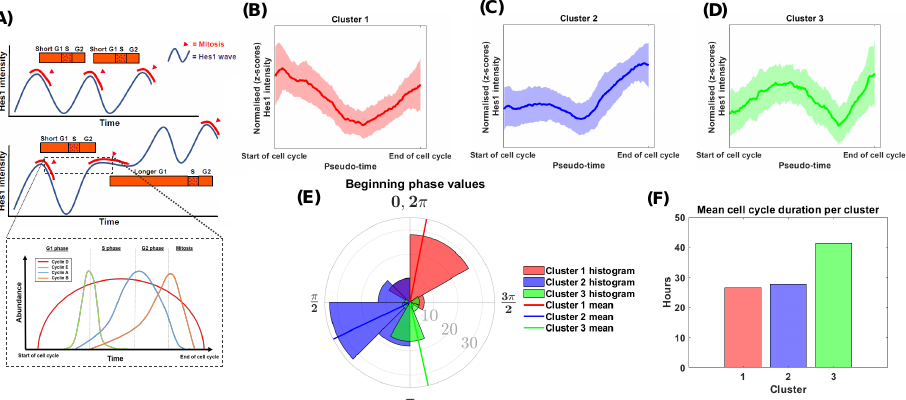
Figure 1. Graphs and schematics representing the results in [26]. ( A ) Schematic illustrating that cell division at a peak in Hes1 yields regular and consistent cell cycle durations ( top panel ) whereas division at a trough gives rise to longer cell cycles (middle panel). Schematic of cyclins (cell cycle proteins) that rise and fall in abundance once every cell cycle ( bottom panel ). ( B – D ): There exist three distinct mitosis to mitosis dynamic behaviours of normalized (z-scored) Hes1 expression: Cluster 1 with high-low-high, Cluster 2 with medium-low-high and Cluster 3 with low-high-low- high dynamics (red, blue, green lines, respectively, shading is ± one standard deviation). ( E ) The momentary position within the oscillation (i.e., the phase that we define in Section 2) at the beginning of the cell cycle of each cell (total n = 164) is plotted as a polar histogram and separated by cluster classification. Means are marked by radial lines. ( F ) Bar chart of mean cell cycle duration of breast cancer cells per cluster. The cells whose Hes1 expression dynamics are classified as Cluster 3 show significantly ( p < 0.0001) longer cell cycles than those in Clusters 1 or